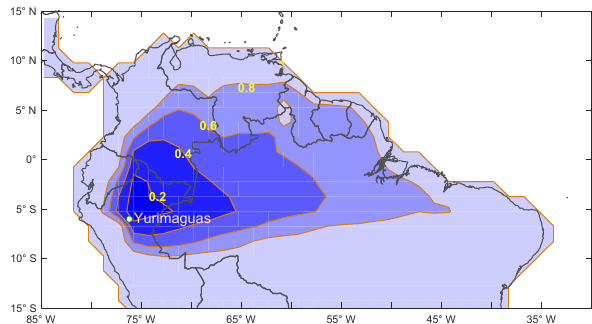
Figure 1. The precipitationshed of the Yurimaguas area. The con- tour value represents the cumulative fraction of Yurimaguas’ rain- fall that comes from the source region delimited by the contour, over the precipitation originating from the South American continent. Thus, the contour line delimiting the South American continent has the value